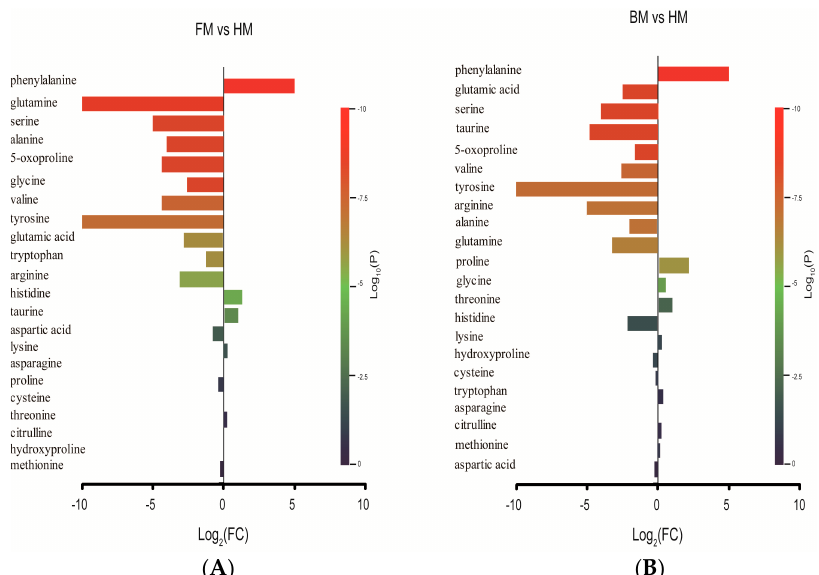
Figure 4. Bar plot of the amino acid changes for the comparison of FM vs. HM ( A ); and BM vs. HM ( B ). A fold change (FC) value for each amino acid (X) was calculated as follows: X fold change = (X level in FM or BM /X level in HM ). Each bar representing an FC value was colored to indicate its corresponding p -value and thereby to specify the statistical significance of the difference (see the color scale). The FC value was normalized by log2 transformation, and the p -value was normalized by log10 transformation. HM, human breast milk; FM, formula milk; BM, bovine milk.